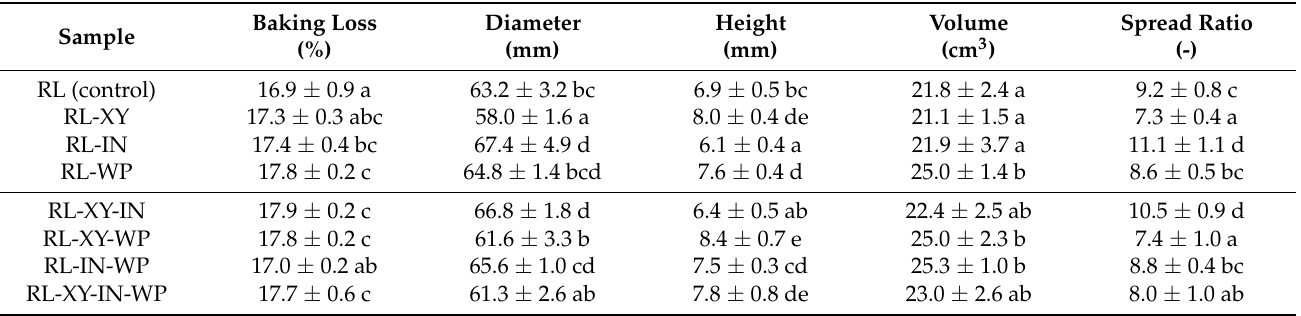
Table 3. Baking loss and geometry of red lentil